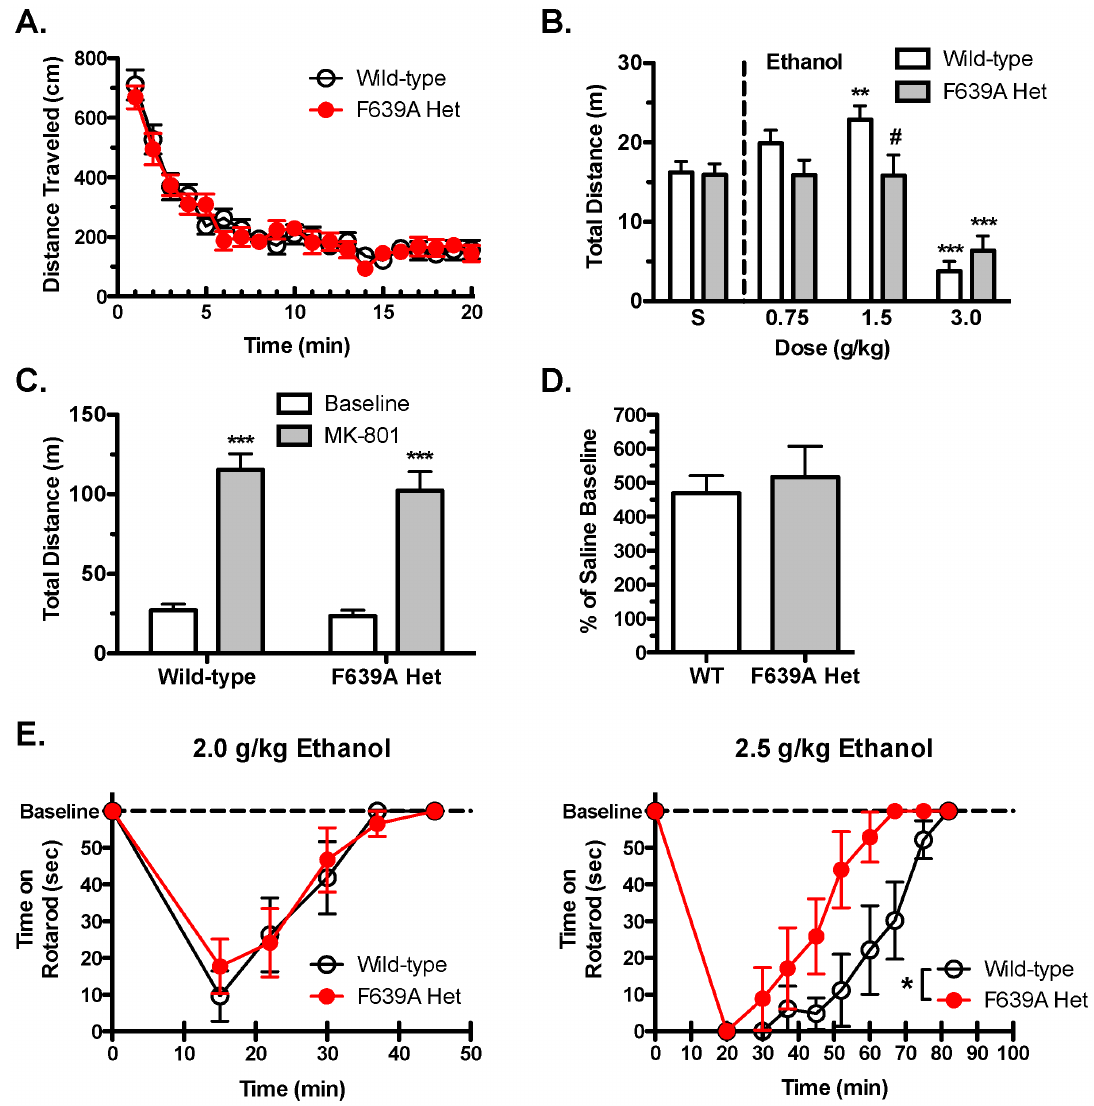
Figure 4. Locomotor stimulating effects of ethanol are blunted in F639A Het mice. ( A ), Baseline spontaneous locomotor activity in saline- treated wild-type and F639A Het mice (n=15 for each group). Distance (mean 6 SEM) traveled shown in 1 min-bins. ( B ), Summary plot showing total distance (mean 6 SEM) traveled by mice during a 10 min period following injection of either saline or ethanol. Symbol ( * ): value significantly different from saline ( ** p , 0.01, *** p , 0.001, two-way RM ANOVA, Bonferroni’s post hoc test); ( # ) value significantly different from wild-type ( # p , 0.05, two-way RM ANOVA, Bonferroni’s post hoc test). ( C ), Total distance (mean 6 SEM) traveled by wild-type and F639A Het mice during a 10 min test period after treatment with saline (baseline) or MK-801 (0.3 mg/kg) (n=7 for each group). Symbol ( * ): value significantly different from saline ( *** p , 0.001, two-way RM ANOVA, Bonferroni’s post hoc test). ( D ), Total distance (mean 6 SEM) traveled under acute MK-801 treatment shown as percent of baseline (saline) treatment. ( E ), Time (mean 6 SEM) spent on a fixed-speed rotarod following injection of 2.0 g/kg (n=6–7 for each group) or 2.5 g/ kg (n=6–7 for each group) ethanol in wild-type and F639A Het mice. Symbol ( * ): value significantly different from wild-type ( * p , 0.05, two-way RM ANOVA, Bonferroni’s post hoc